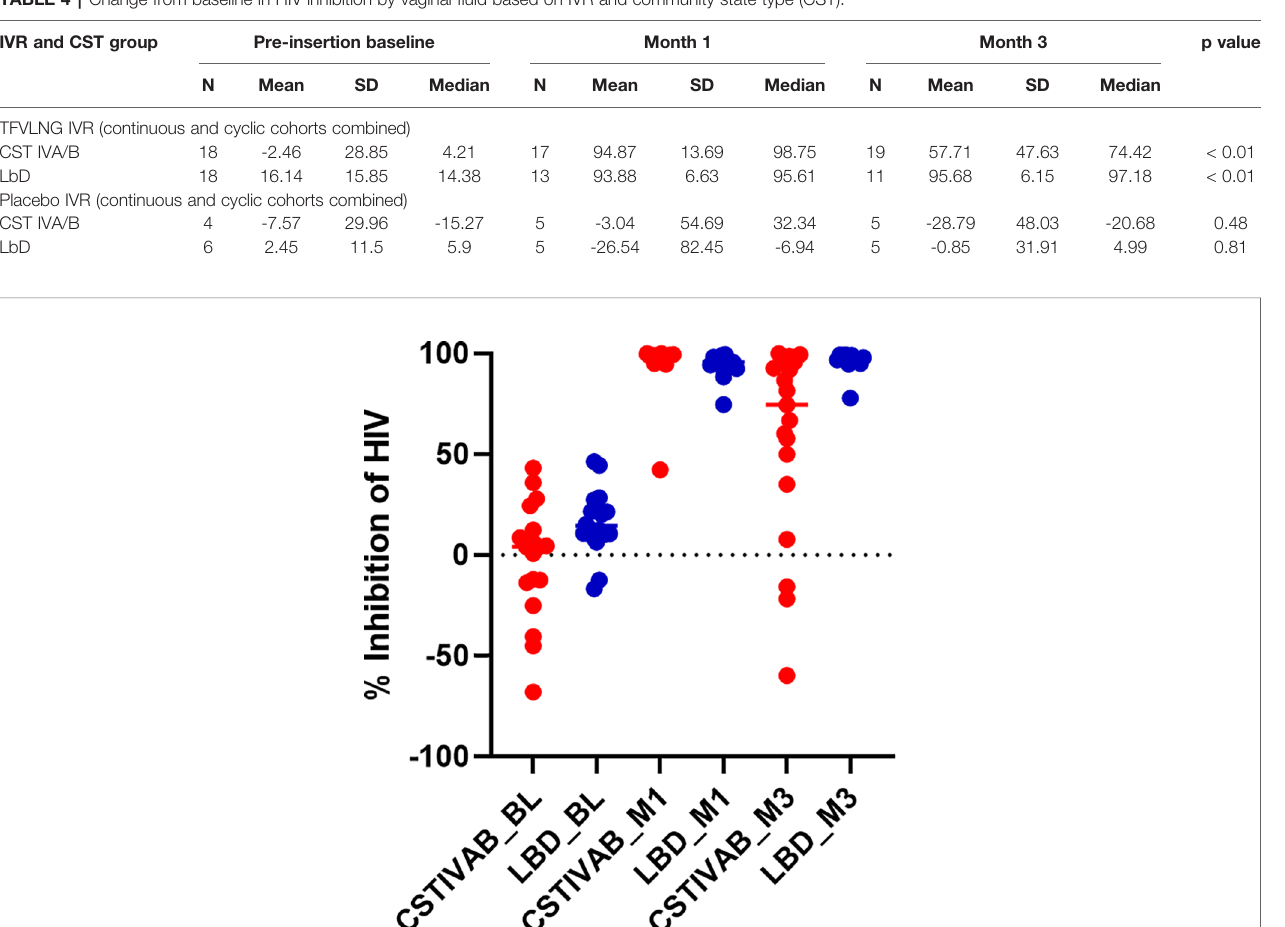
FIGURE 4 | Percent inhibition of HIV in vitro by cervicovaginal fl uid lavage (CVL) supernatant obtained from study participants using the TFV/LNG IVR at baseline (BL) pre-insertion, month 1 (M1), and end of treatment month 3 (M3). Red dots represent participant data from individuals with diverse anaerobic CST IVA/B microbiota at sampling. Blue dots represent participant data from individuals with Lactobacillus-dominated (LbD) microbiota at sampling. p values < 0.01 paired change from BL in percent HIV inhibition at months 1 and months 3 for both LbD and CST IVA/B